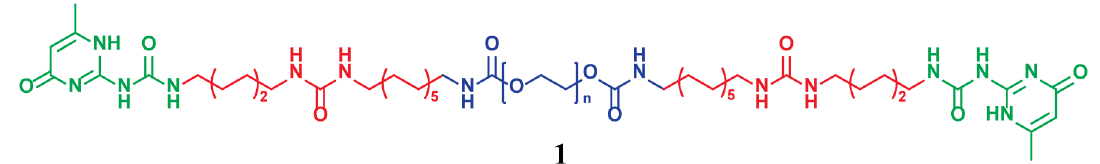
Figure 1. Chemical structure of the supramolecular UPy-PEG hydrogelator: = 10 kDa, n ≈ 227 for 1a ; M = 20 kDa, n ≈ 454 for 1b ) poly(ethylene glycol) (blue, M n n end-functionalized with ureido-pyrimidinone (UPy) groups (green), which are flanked by hydrophobic spacers containing urea groups